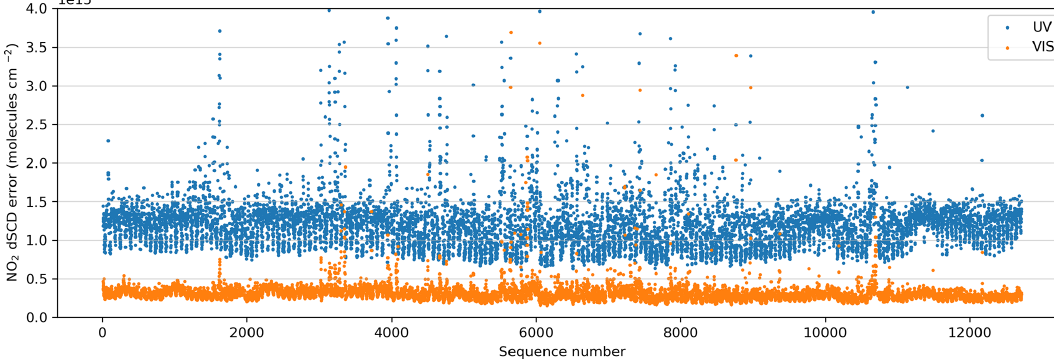
Figure A1. DOAS fit errors of the NO 2 retrievals in the UV and visible wavelength windows.